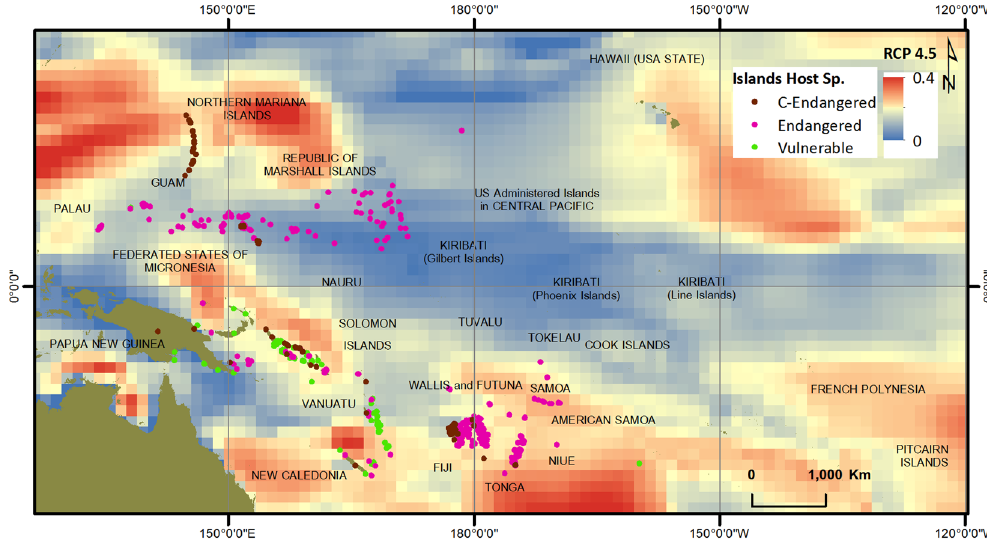
Figure 4. Critically endangered, endangered and vulnerable species on RCP4.5 Hs projections. (Figure generated using ARCGIS 10.3, http://www.esri.com/).